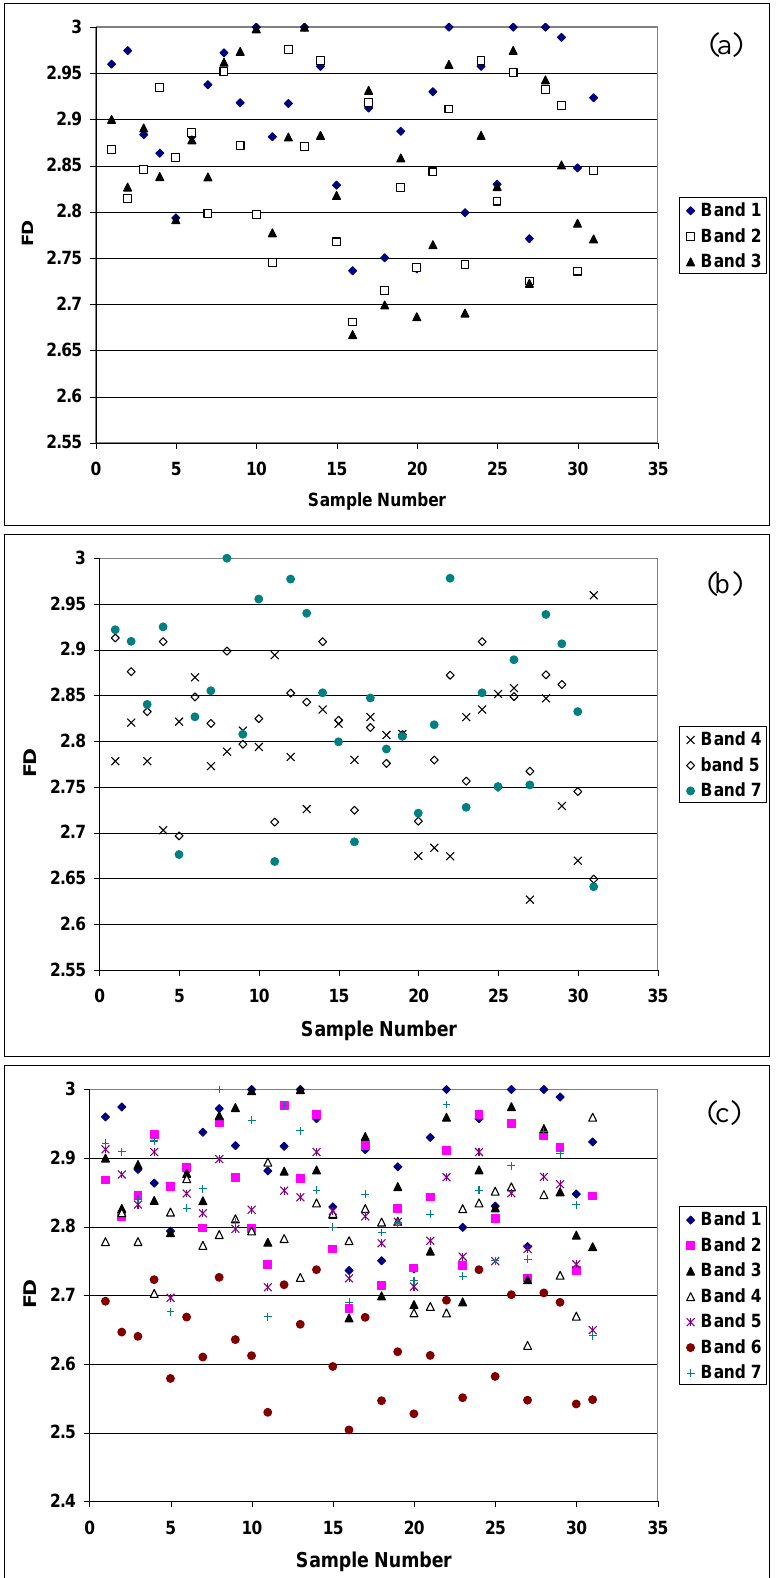
Figure 15. Fractal dimension values of samples within Chattahoochee National Forest: (a) visible bands (b) near and middle infra red bands (c) all